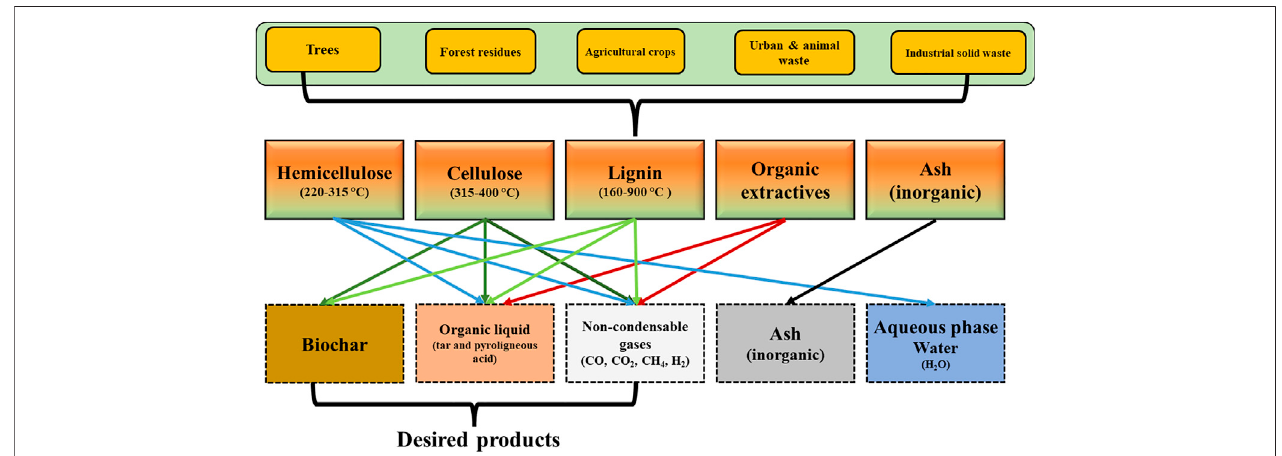
FIGURE 3 | Lignocellulosic biomass degradation during pyrolysis (adapted and redrawn from Zhang et al., 2019).